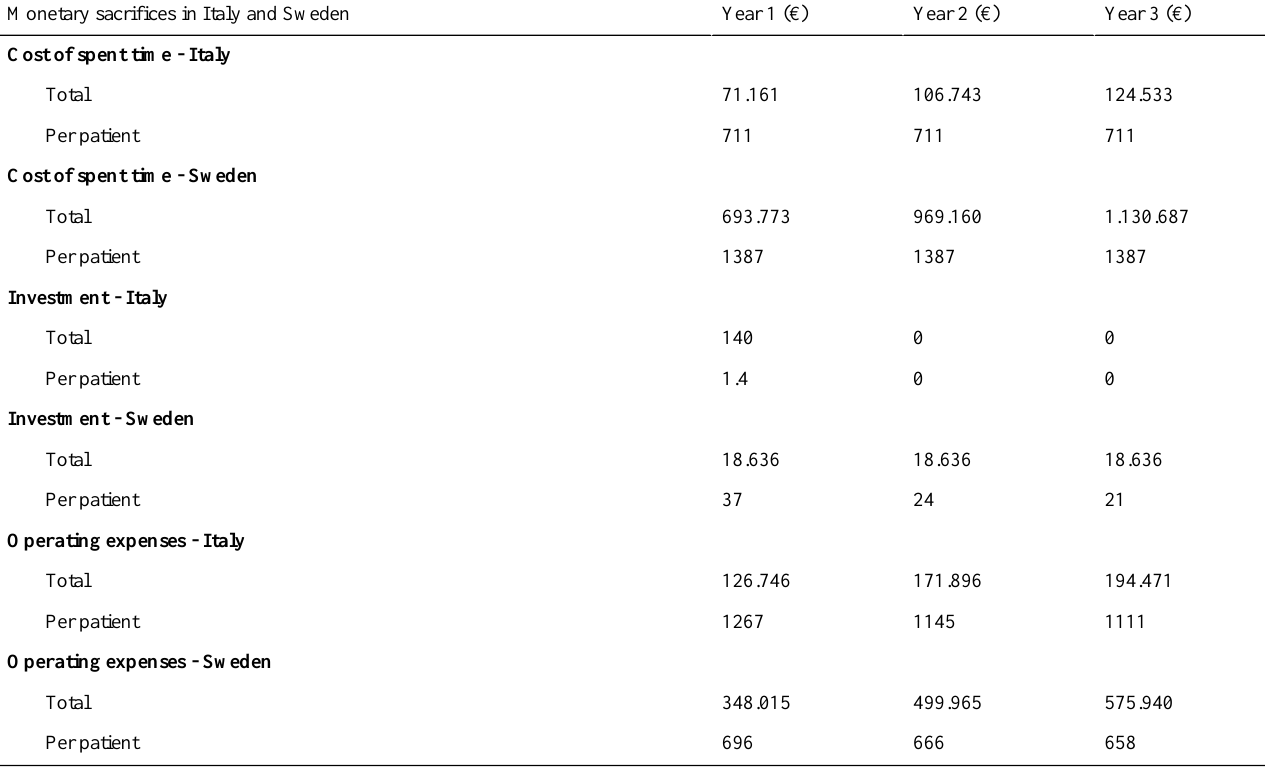
Table 3. Monetary sacrifices, in euros (a currency exchange rate of EUR €1=US $1.18 is